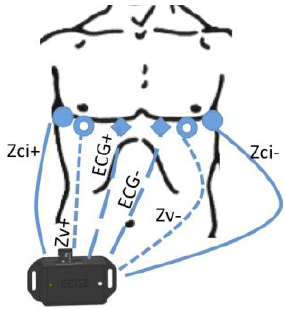
Figure 3. Drawing of the ECG/ICG measuring device indicating the connection with the biopotential and the TEB textrodes placed on the torso for performing ECG and respiration